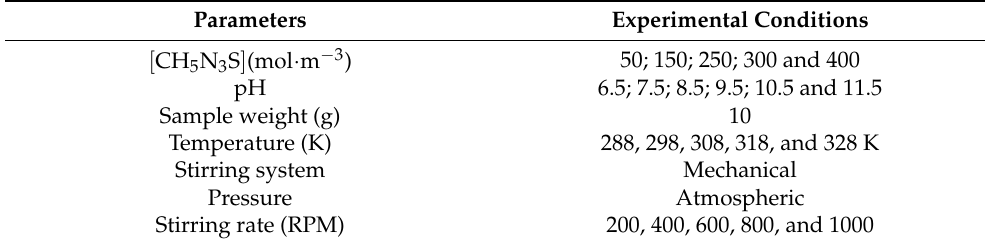
Table 1. Experimental conditions were used for the study of leaching of